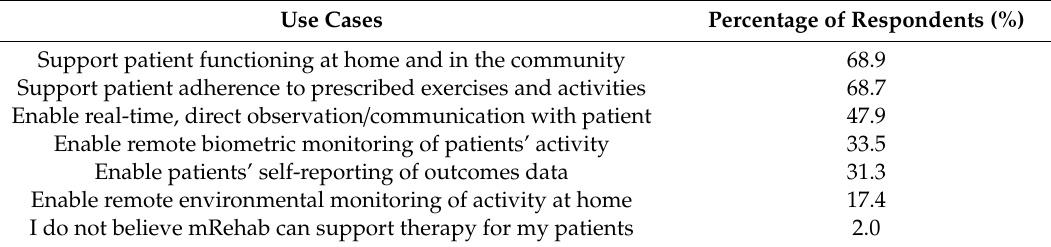
Table 10. Most critical use case for mRehab, all professions, all professions (select top